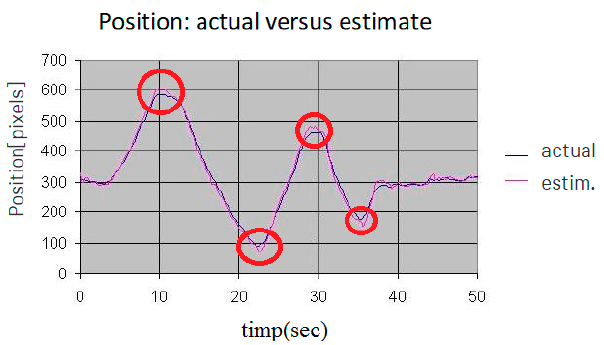
Figure 6. Position prediction (blue—actual, red—filter prediction) and first derivative sign change errors.